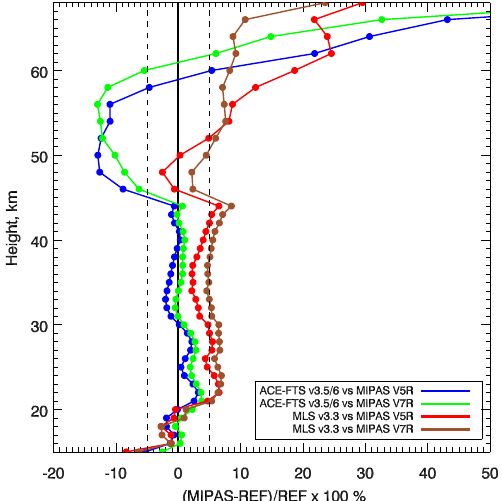
Figure 7. Bias between old and new versions of MIPAS ozone data and the ACE-FTS and MLS profiles. The altitudes at which the bias is significant at the 2 σ level are highlighted by circles. The averages over the whole globe are